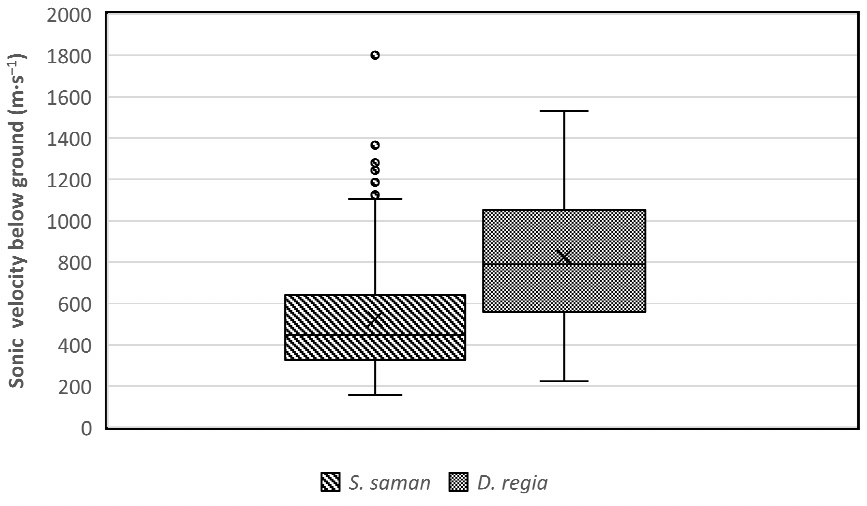
Figure 7. The sonic velocity (m · s − 1 ) detected by the Root Detector for Samanea saman and Delonix regia Figure 7 . The sonic velocity (m ∙ s − 1 ) detected by the Root Detector for Samanea Saman and Delonix regia .